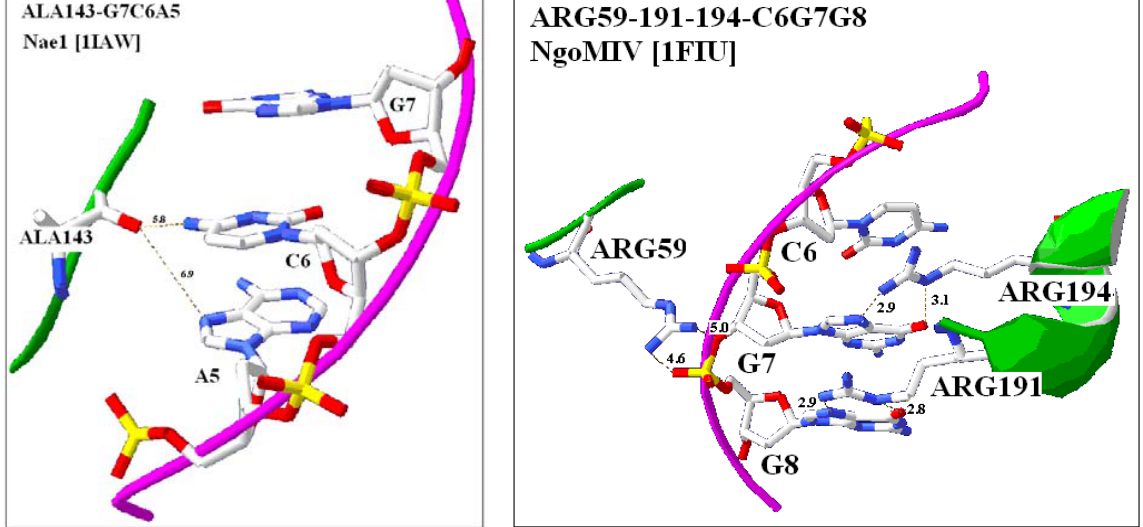
Figure 1. Co-location of Codon-like Triplets and Amino Acids in RE-RS Complexes. Examples for co-locations of amino acids in restrictions endonucleases (RE) and codon- like triplets in restrictions enzyme recognition sites (RS). The name of enzyme, the name and position of nucleic acid bases and amino acids are indicated. Four amino acids located at overlapping-codon like base sequence in Eco RI is indicated in the yellow